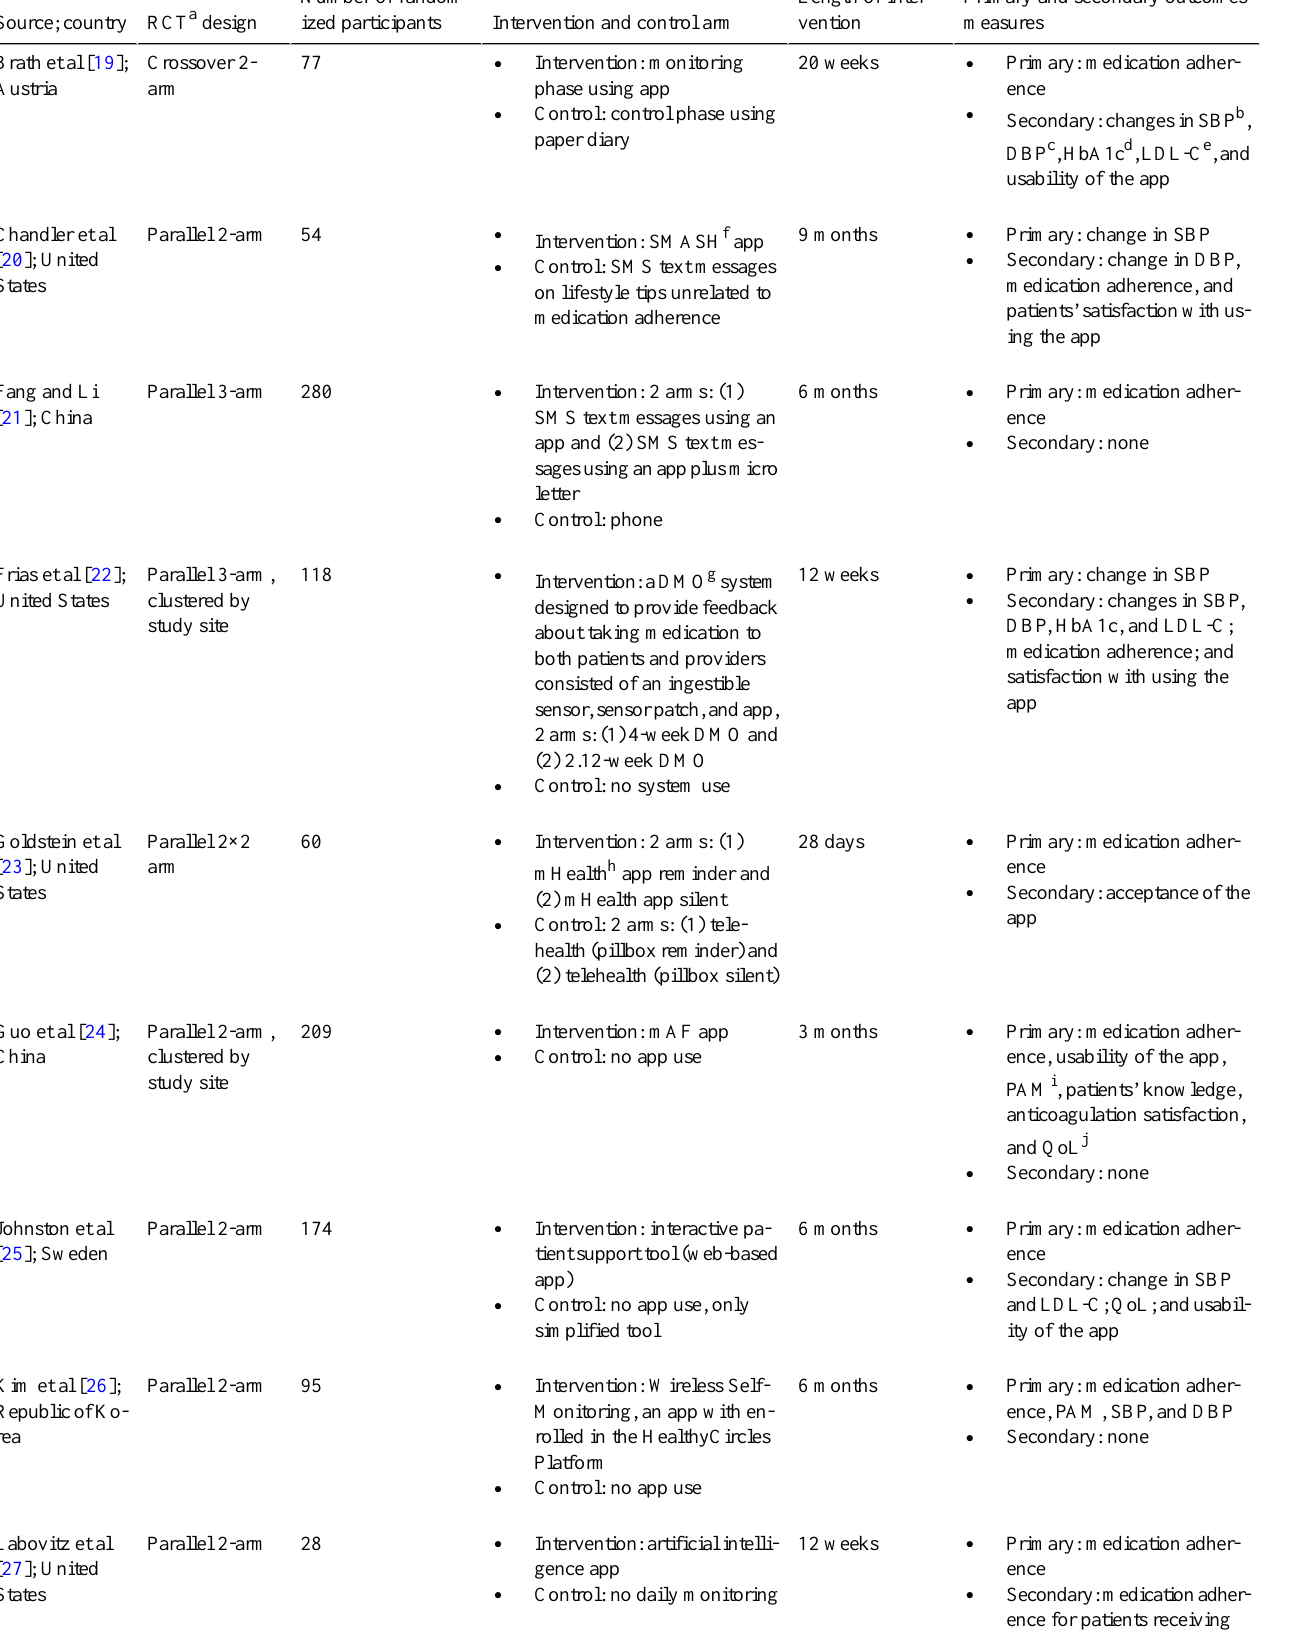
Table 1. Characteristics of the included randomized controlled